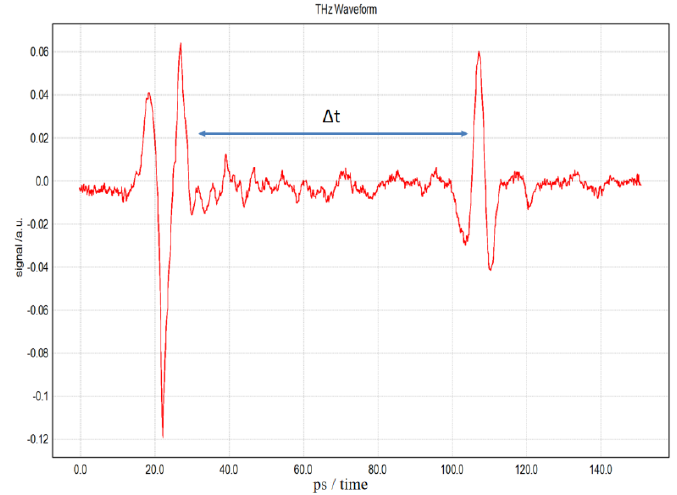
Figure 5. Terahertz time–domain spectroscopy (THz-TDS) pulses from a transmitted glass fiber-